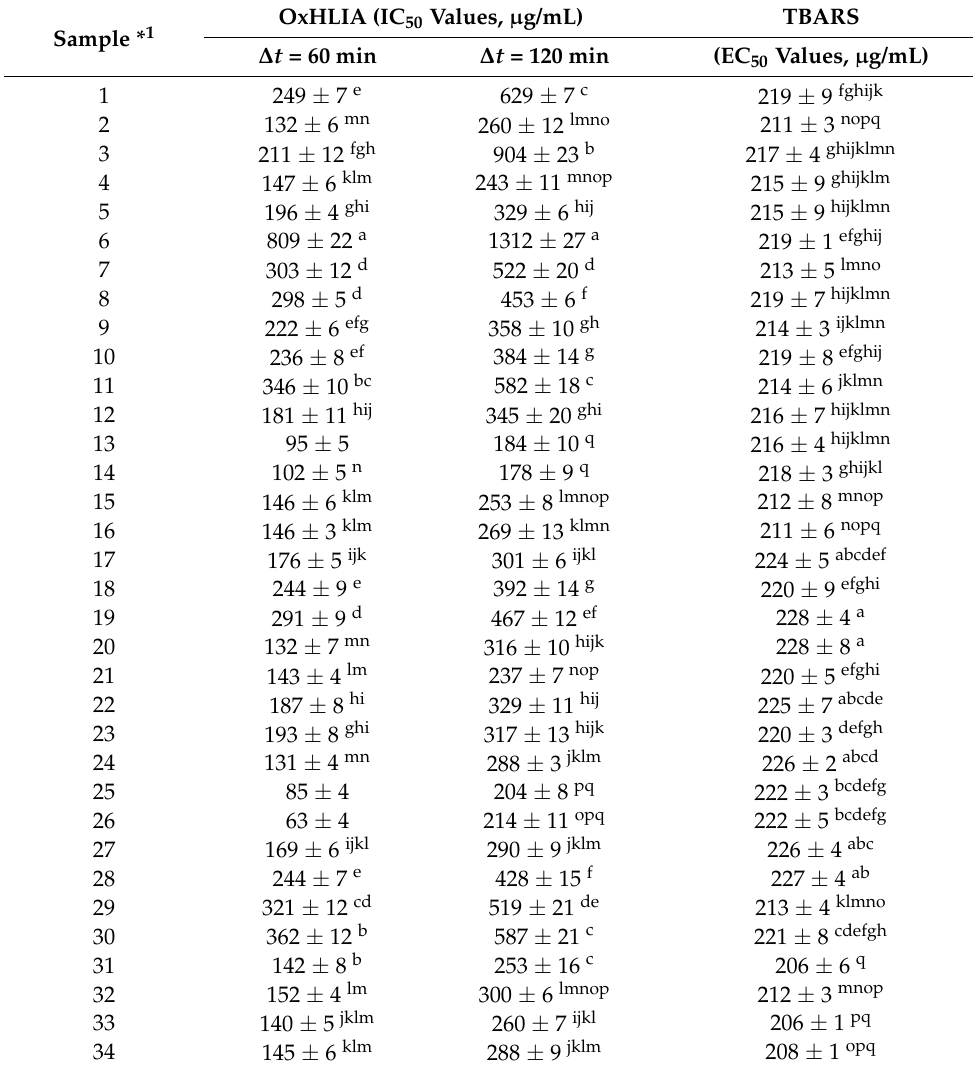
Table 7. Antioxidant activity of the studied Pardina lentil “Lenteja de Tierra de Campos” (mean ± SD; n =